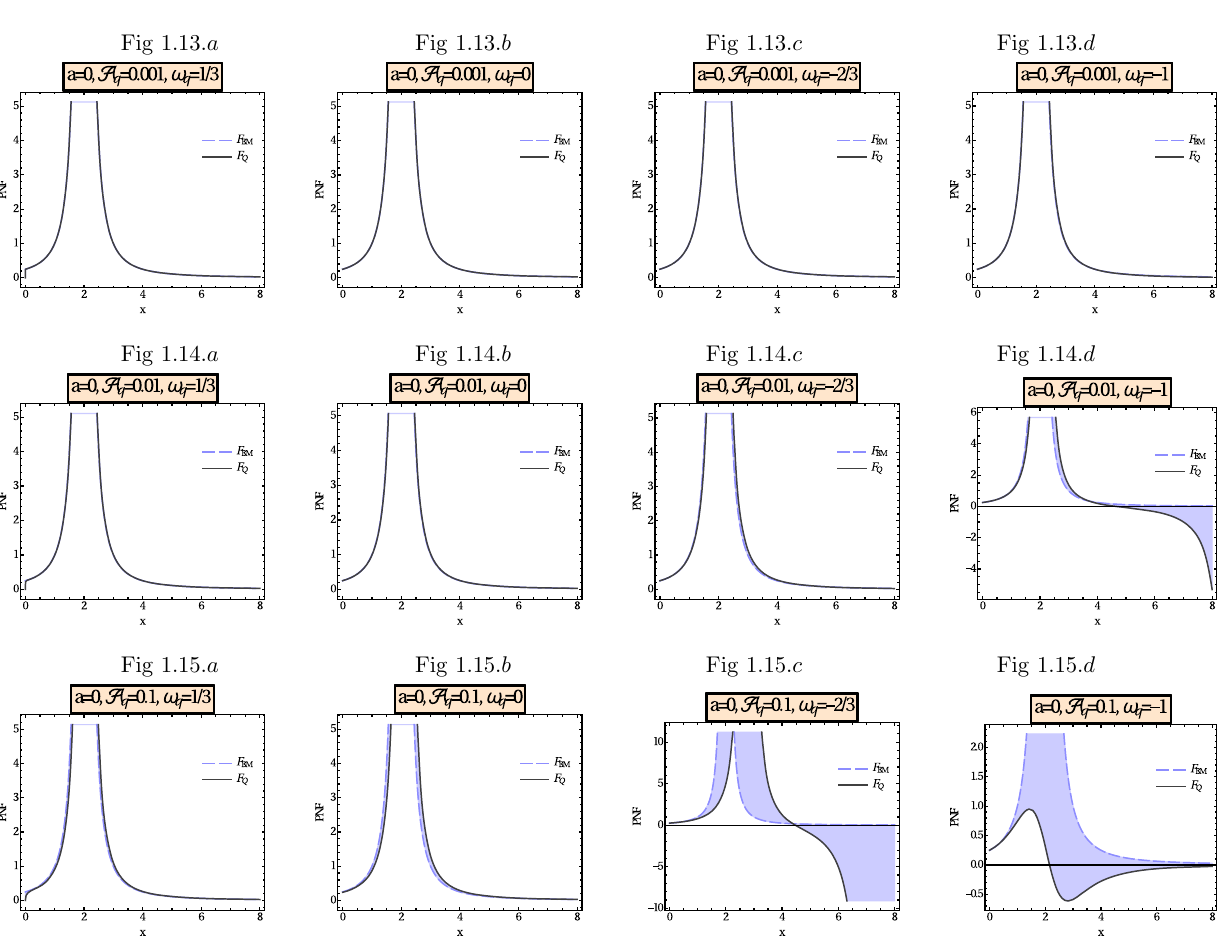
Fig 1 . 13 .a Fig 1 . 13 .b Fig 1 . 13 .c Fig 1 . 13 .d